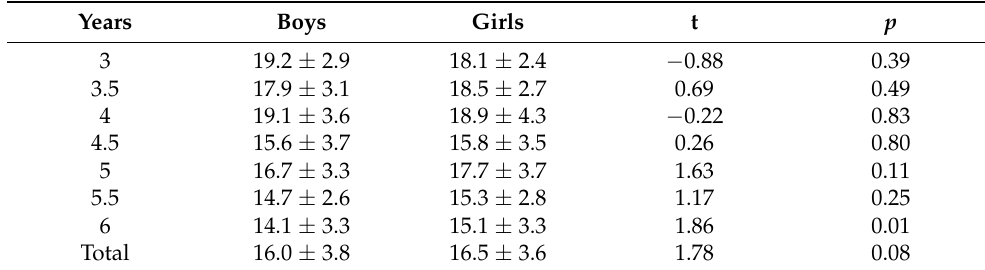
Table 4. Gender difference in BMI ( X ± SD, kg/m 2 ).